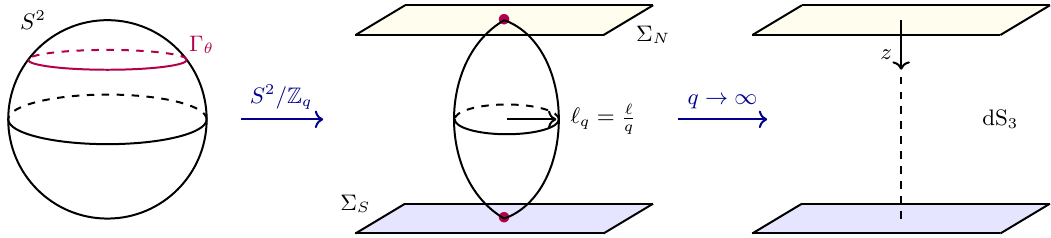
Figure 2 . The large q limit of the spindle S 2 = Z q . This corresponds to the zero radius limit ‘ q ! 0, where the two-dimensional geometry between the northern and southern defects (cid:6) N and (cid:6) S shrinks to a single transverse dimension. The resulting geometry is that of global dS 3